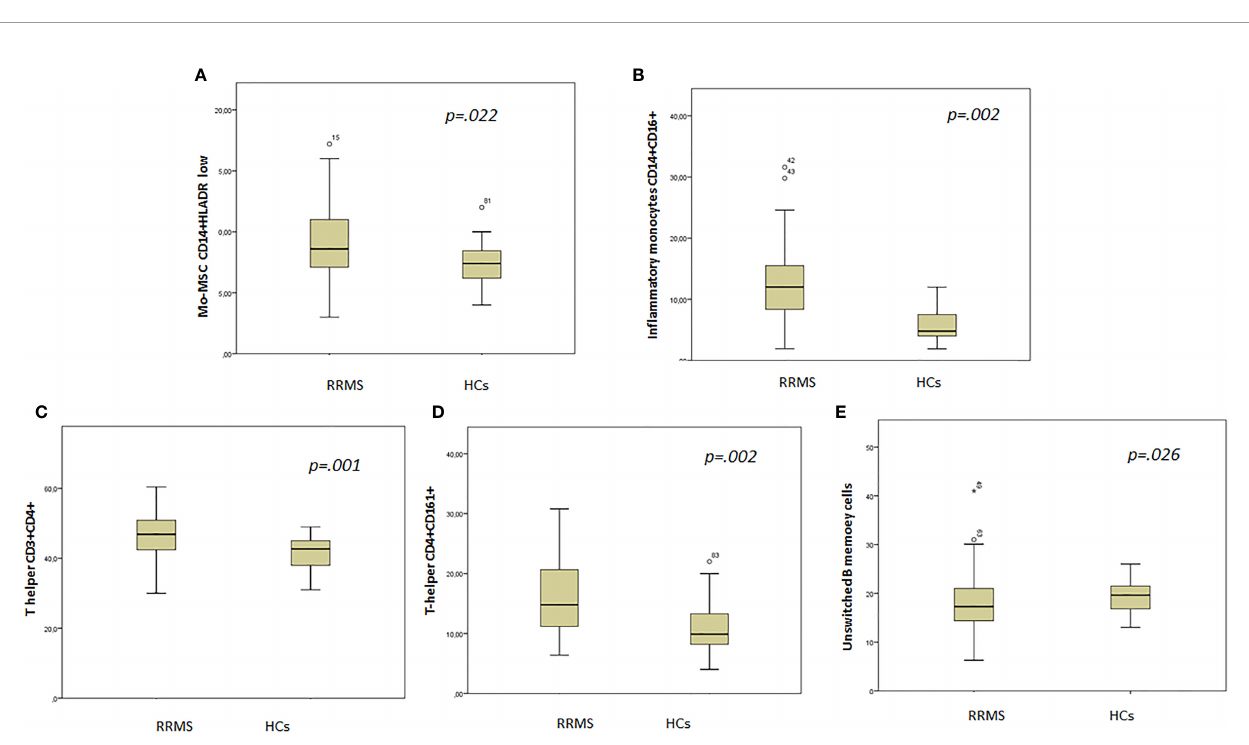
FIGURE 2 | Flow cytometry data showing different cell subset analyses. (A) G-MDSC panel; (B) Mo-MDSC panel; (C) lymphocyte panel; (C1) T cells; (C2) B cells.